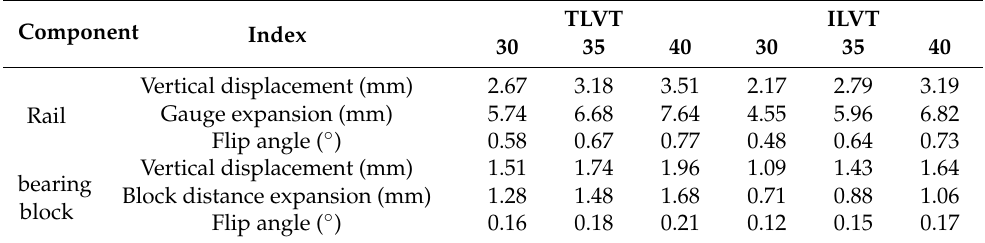
Table 6. Summary of geometric shape and position value under the axle load of 30t and above.